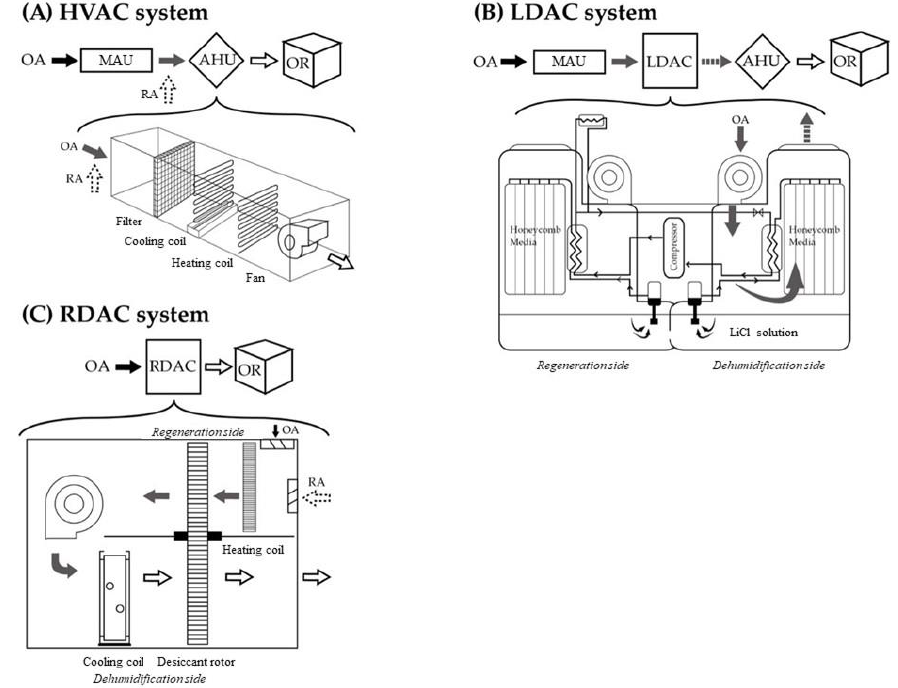
Figure 1. Design diagram of conventional heating, ventilation, and air conditioning (HVAC) ( A ), liquid desiccant air conditioning (LDAC) ( B ), and rotary desiccant air conditioning (RDAC) ( C